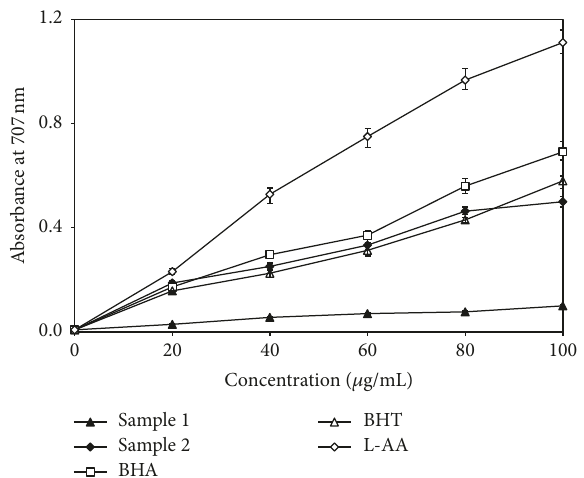
Figure 3: Antioxidant activity of extracts from C. multiflorus sarcocarp measured by reducing power assay. Results are mean ± SD ( 𝑛 = 3 ). Sample 1: the sample extracted by ethanol-water (7: 3, v/v); Sample 2: the sample reextracted from Sample 1 by ethyl acetate.